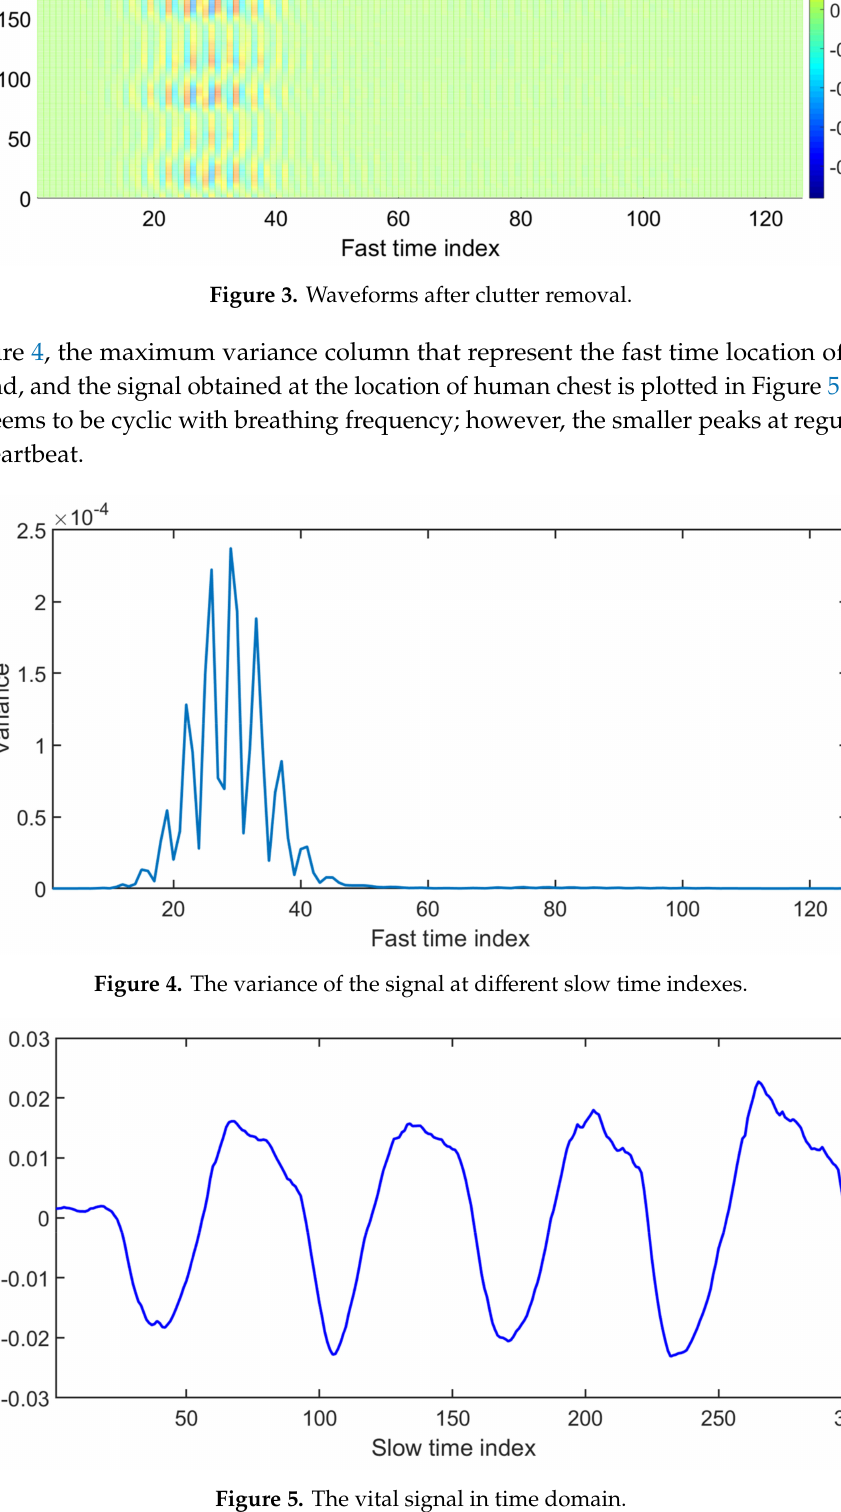
Figure 5. The vital signal in time